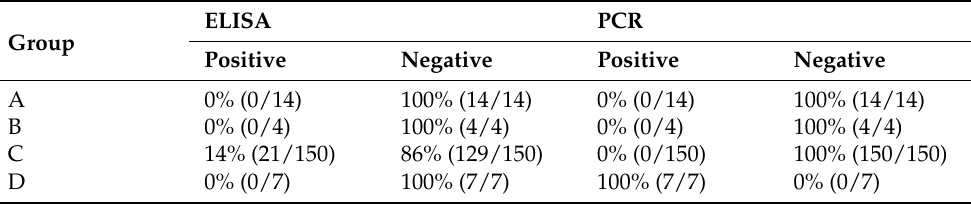
Table 3. Detection of EEHV antibodies using EEHV-DNApol ELISA on various groups of elephant sera.